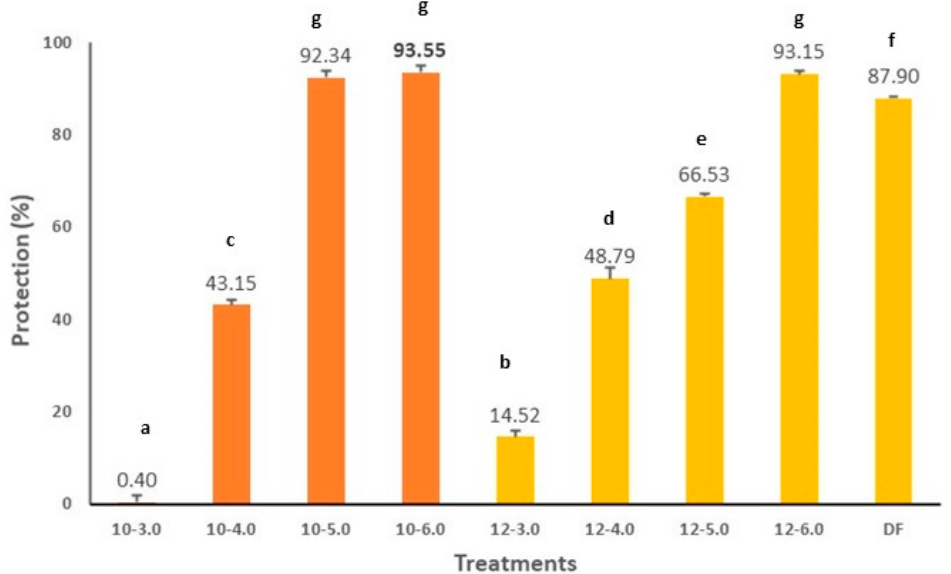
Figure 4. Anti-inflammatory activity of cricket protein concentrate (CPC). Results were expressed as mean ± standard deviation ( n = 3) and were evaluated by one-way Anova and Turkey test ( p < 0.05). Statistical differences were indicated with different letters. DF (diclofenac) control. 4. Conclusions In the near future, insects may become an important source of protein for the human diet and their production is also environmentally sustainable. Many consumers have a certain reluctance to include insects in their diet, therefore their derivatives are an excel- lent alternative so that they can be used by the food industry. These transformations can be in the form of protein concentrates. In addition to containing a high protein content and high gastrointestinal digestibility, CPCs have added biological values such as a strong antioxidant and anti-inflammatory power which could be due to their high content of phenolic compounds. The functional properties allow evaluating the possible uses of the isolates as ingredients in food products. In future research, the different proteins of the CPC, the peptides of the hydrolysates, and the phenolic compounds could be identified with the help of mass spectrometry. Supplementary Materials: The following supporting information can be downloaded at: www.mdpi.com/xxx/s1, Figure S1: Cricket protein concentrate (CPC), the uncropped western blot figures were presented . Figure S2: hydrolysates from cricket protein concentrate (CPC) Author Contributions: Conceptualization, M.F.Q., A.B. and J.M.; methodology, M.R. , W.C. and A.B.; software, M.F.Q.; validation, M.F.Q., J.M. and M.R., A.B.; analysis, M.F.Q.; investigation, M.F.Q.; resources, M.F.Q.; data curation, M.F.Q. and M.R.; writing-original draft preparation, W.C.; writing—review and editing, W.C.; visualization, W.C.; supervision, W.C.; project administration, W.C. All authors have read and agreed to the published version of the manuscript. Funding: This research received no external funding. Institutional Review Board Statement: Not applicable. Informed Consent Statement: Not applicable. Data Availability Statement: Not applicable. Acknowledgments: Project N° 001-CI-UEB-2017, Hydrolyzed proteins of animal and vegetable origin with antimicrobial and antioxidant capacity for different uses in the agroindustry. Conflicts of Interest: The authors declare no conflict of interest. References 1. Department of Economic and Social Affairs, Population Division, United Nations. World Population Prospects: The 2017 Revision, Key Findings and Advance Tables ; Working Paper No. ESA/P/WP/248 ed; United Nations: New York, NY, USA, 2017.